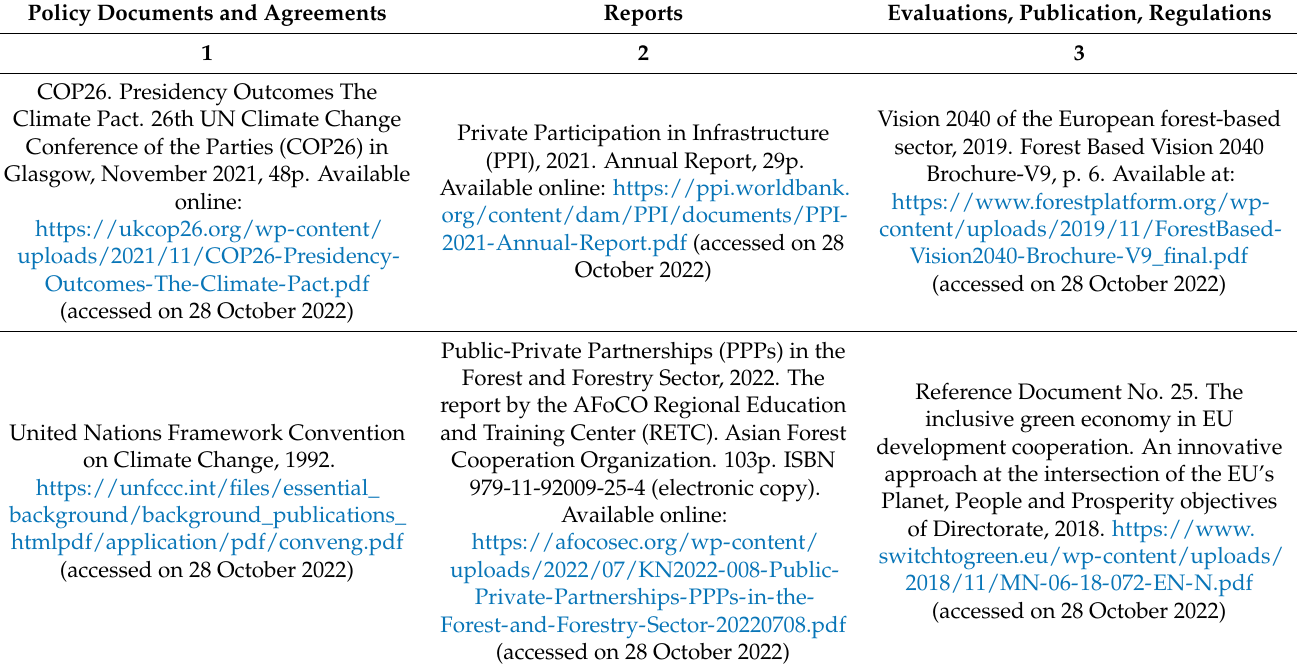
Table 1. Key documents regarding the study of PPP in the field of sustainable forest